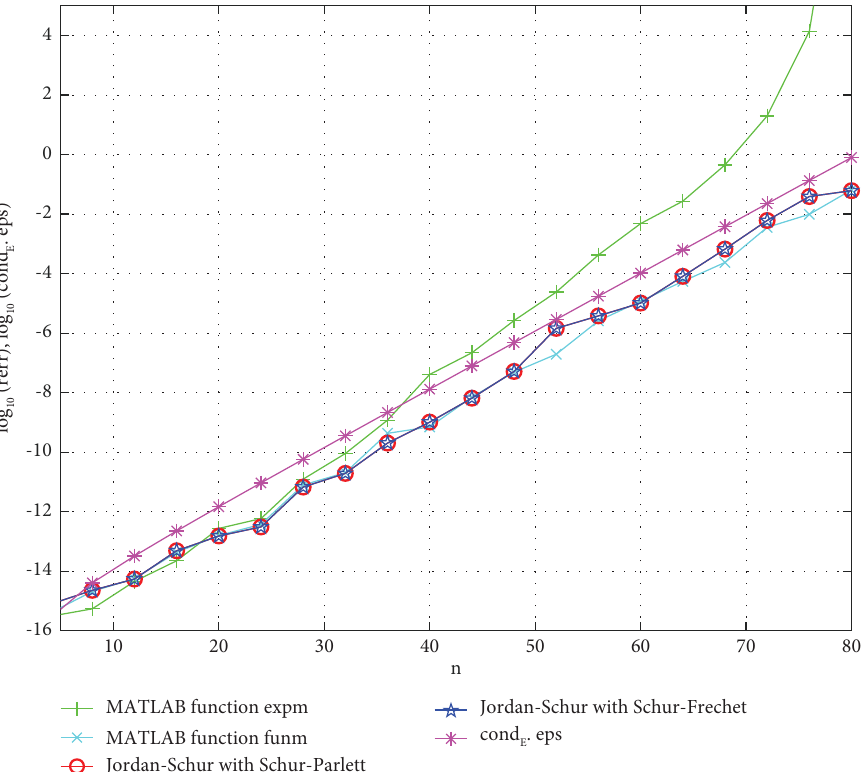
Figure 3: Relative errors for Experiment